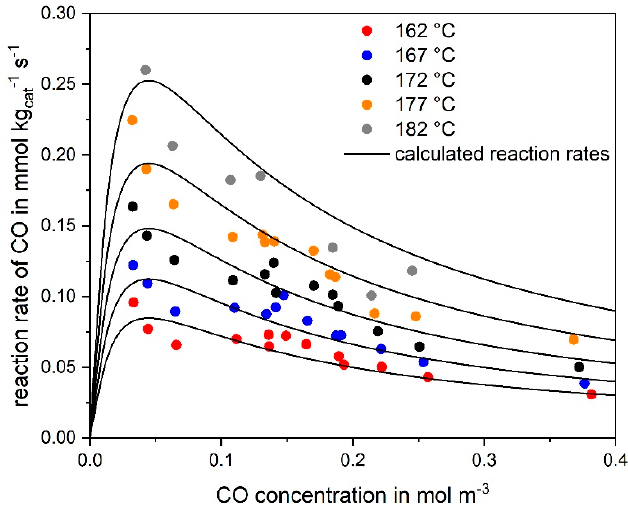
Figure 1. Reaction rate of CO conversion at different CO concentrations (but constant H 2 concentration) for different temperatures (marks) compared to the curve fitting according to the Langmuir–Hinshelwood rate expression (solid lines) (0.12–1.4 vol% CO, 55 % H 2 , rest N 2 , m cat = 2 g, 162–182 ◦ C, 1 bar).